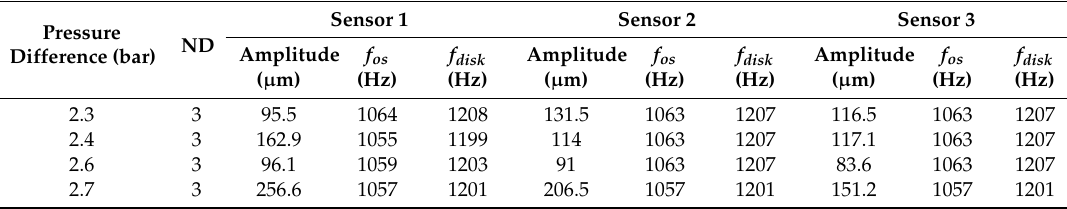
Table 9. Results for the second prototype at 2 × RPM nominal .